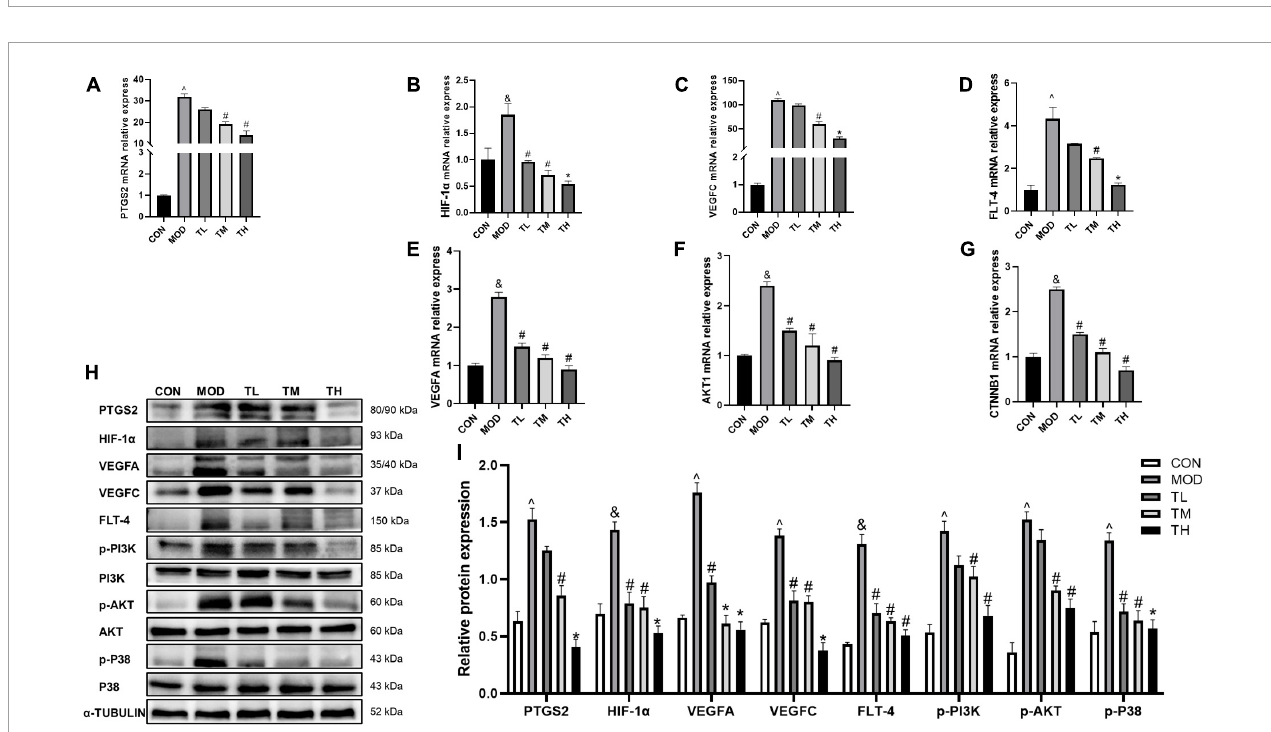
FIGURE11 Effects of THD on prediction targets and pathways in AS Mice. (A–G) Aorta gene expression of PTGS2, HIF-1 α , VEGFA, VEGFC, FLT-4, AKT1, CTNNB1 were detected by RT-qPCR, n = 3. (H) Protein expression of PTGS2, HIF-1 α , VEGFA, VEGFC, FLT-4, PI3K, p-PI3K, AKT, p-AKT, P38, and p-P38 in the aortas were investigated by Western blot, n = 3. (I) The quantitative results of the western blot were depicted. MOD group was compared to the CON group, and THD was compared with the MOD group. α -TUBLIN was used as an internal reference. Data are expressed as mean ± SEM. & P < 0.05, ∧ P < 0.01 vs. CON group; # P < 0.05, * P < 0.01 vs. MOD